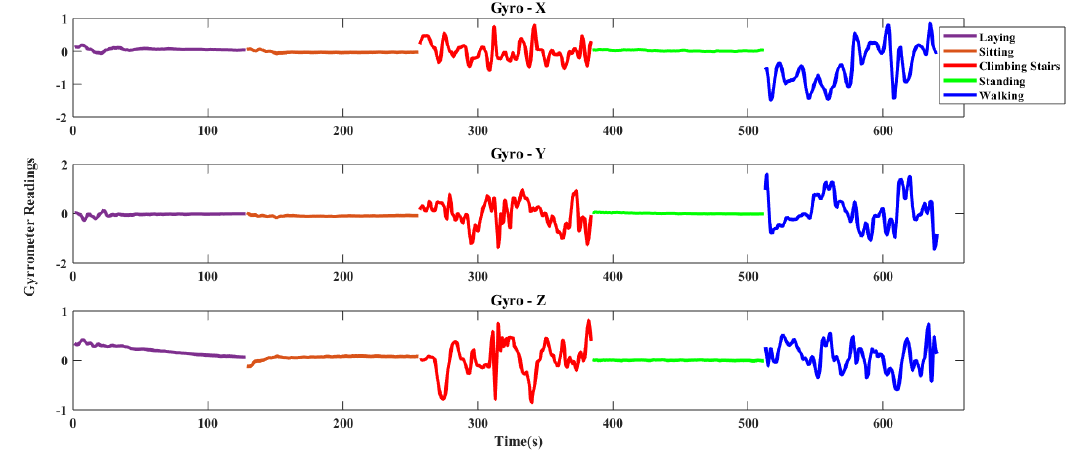
Figure 6. Triaxial Gyroscope data of UCI-HAR